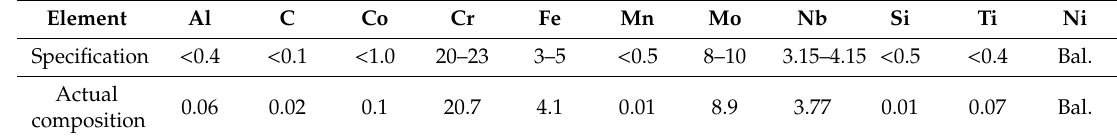
Table 1. Chemical composition of IN 625 metal powder (in wt.